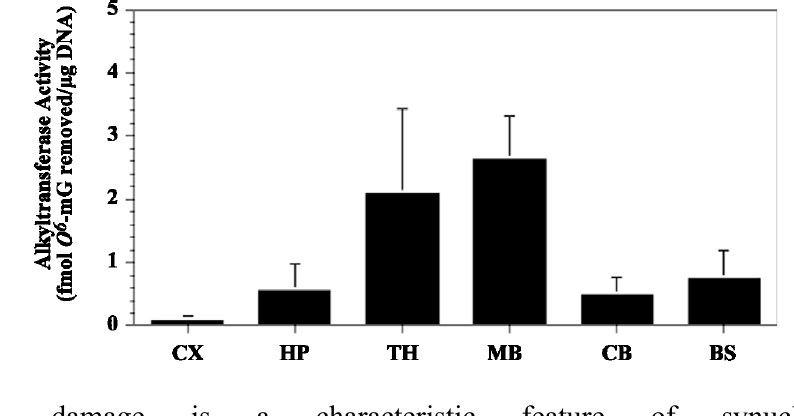
Figure 8. O 6 -Methylguanine methyltransferase (MGMT) activity in various brain regions of neonatal mice. Protein extracts (100  g) from postnatal (6–8) brain tissue of wild type (C57BL6) mice (n = 3) were incubated with [ 3 H]-methyl-DNA and the amount of [ 3